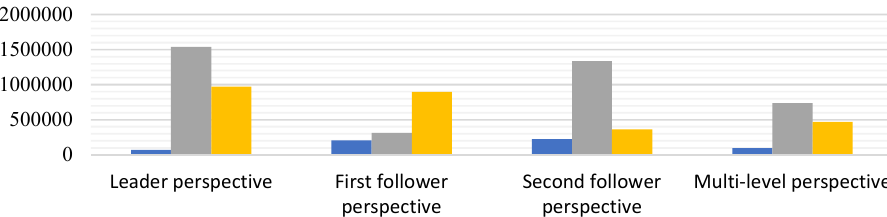
Fig. 3. objective functions of the proposed model from different points of view for first three periods